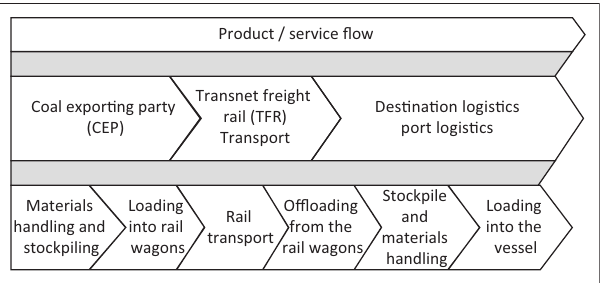
FIGURE 3: The product flow activities at the different stages in the bulk coal export logistic chain.